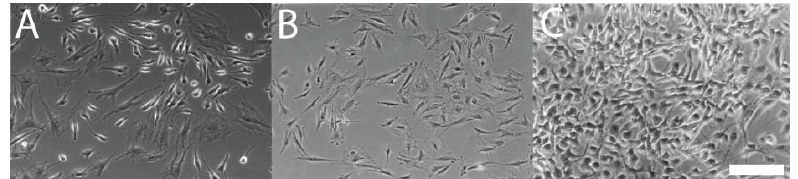
Figure 2. Bone marrow stem cells seven days after subculture on (A) an uncoated glass slide, (B) an uncoated polystyrene tissue culture dish, (C) on a glass slide coated with nano-porous titania. Scale bar 50 µm.